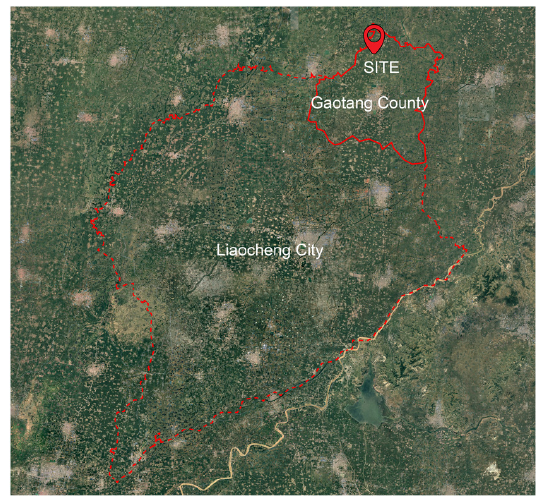
Figure 3. Liaocheng City map.